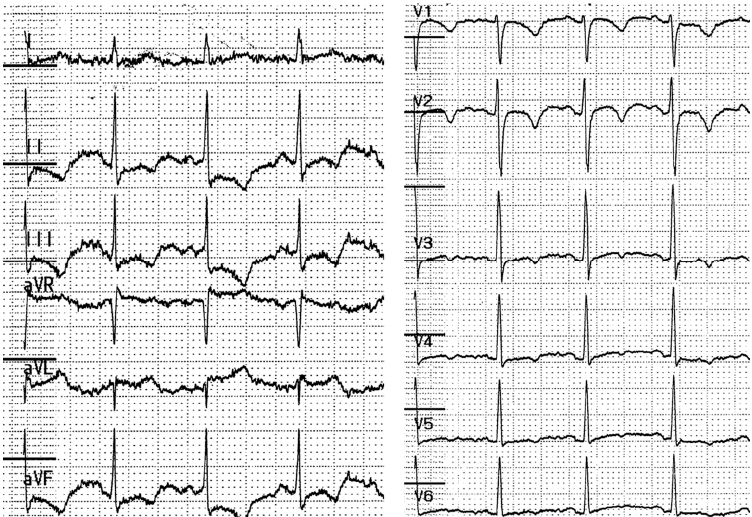
Figure 2. Electrocardiogram obtained when the patient complained of transient chest discomfort. ST depression and negative T waves were recorded in leads II, III, and aVF.